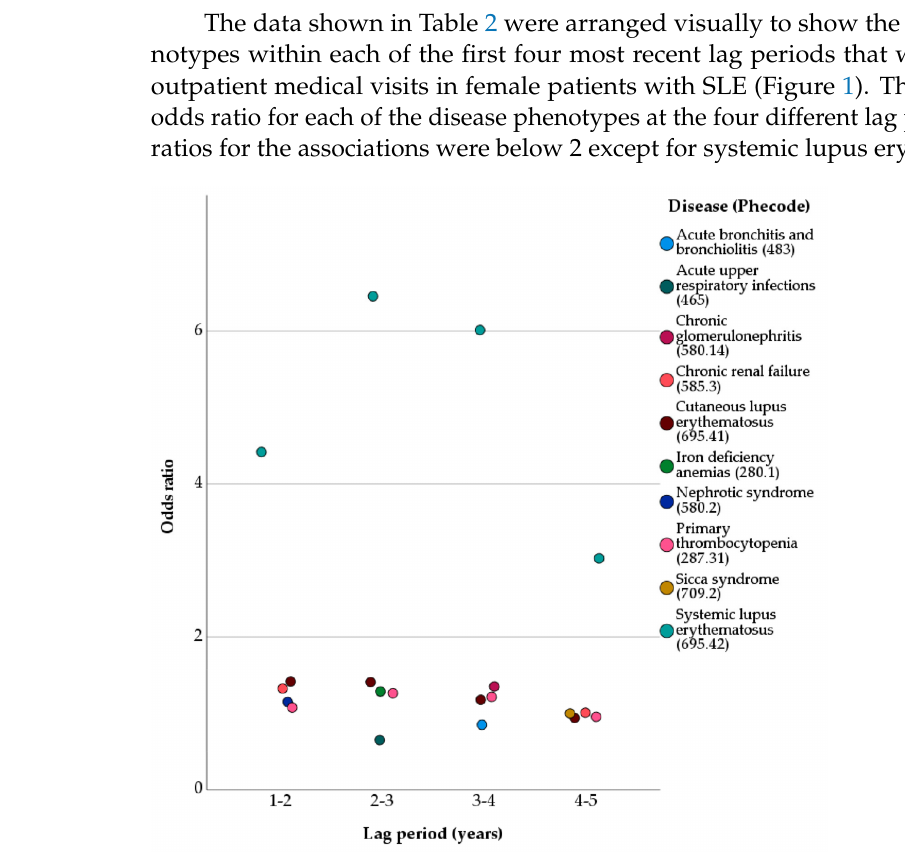
Figure 1. Top five disease phenotypes with the first four most recent lag periods that were associated with outpatient medical visits in women with systemic lupus